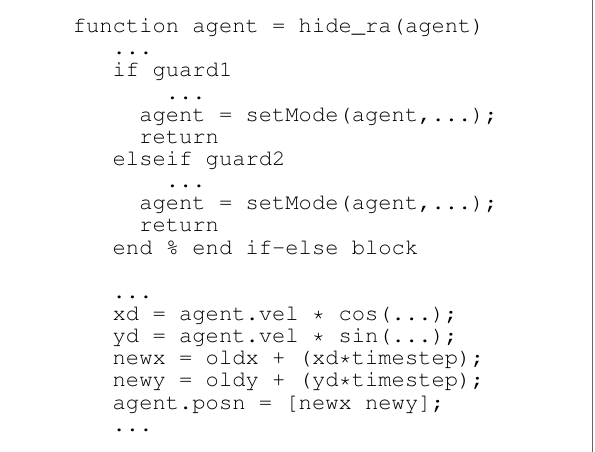
FIGURE 5 | The basic code structure of the simulator in MATLAB . FIGURE 6 | The basic code structure of a mode in MATLAB for a hybrid dynamical agent